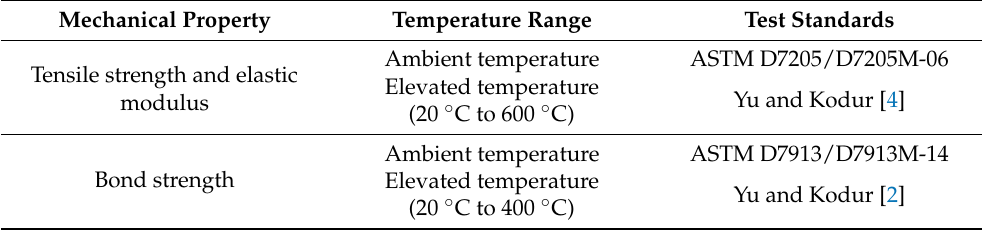
Table 3. Test standards and temperature range for the evaluation of mechanical properties of FRP. Mechanical